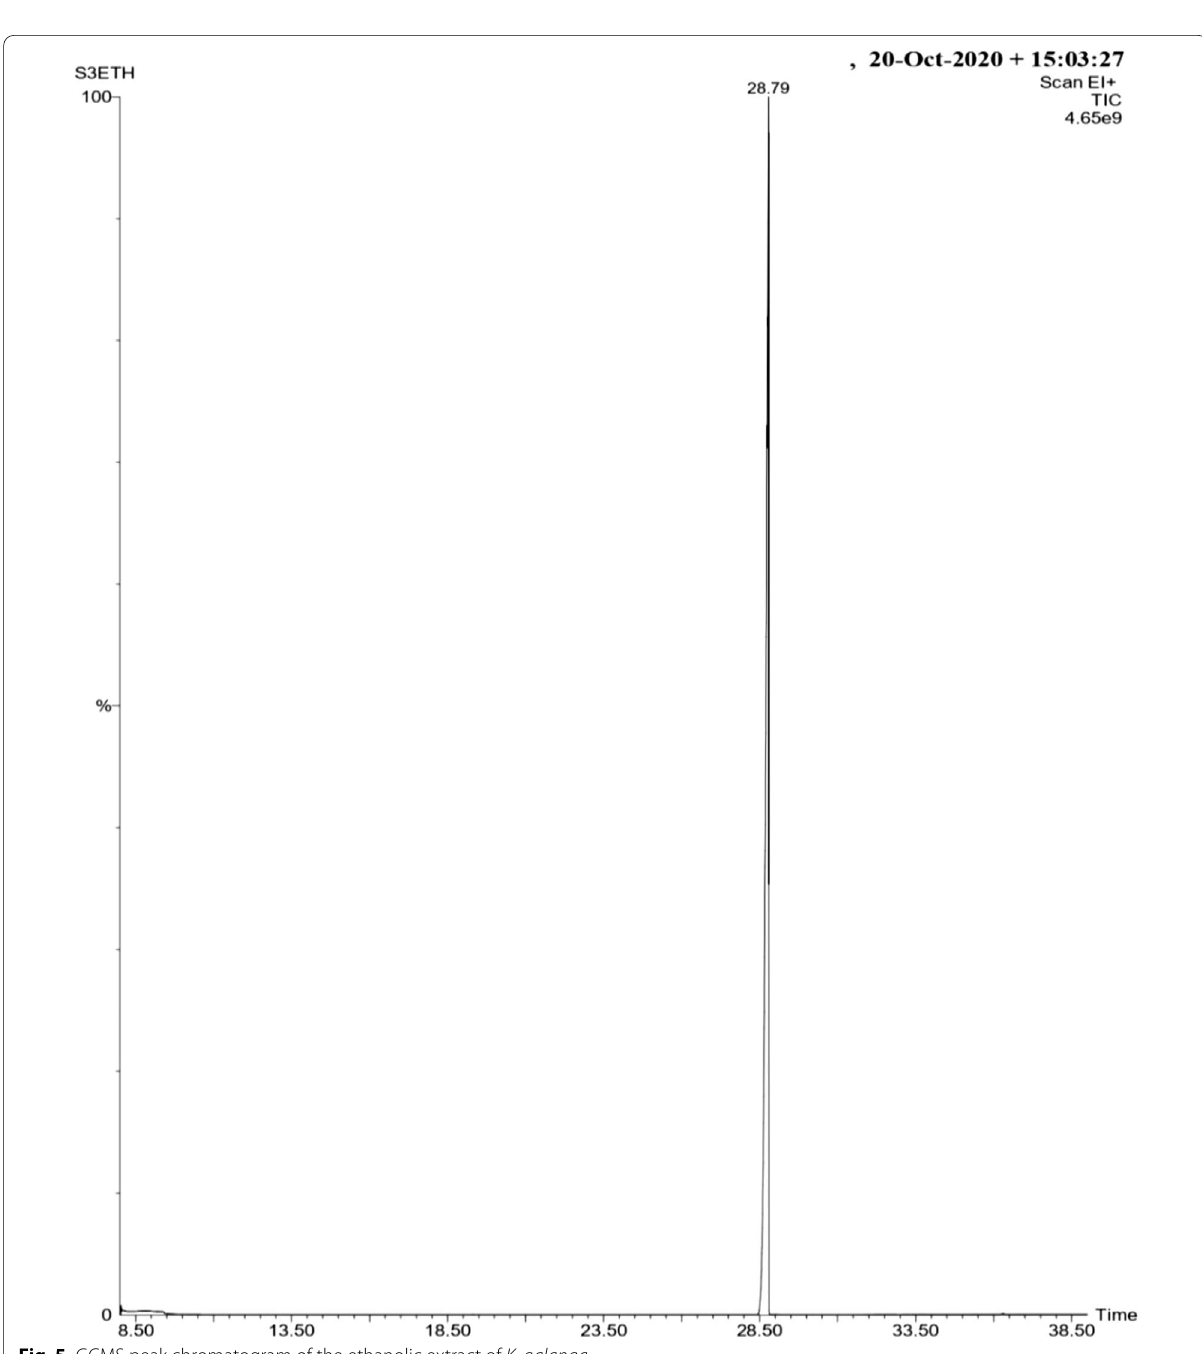
Fig. 5 GCMS peak chromatogram of the ethanolic extract of K.